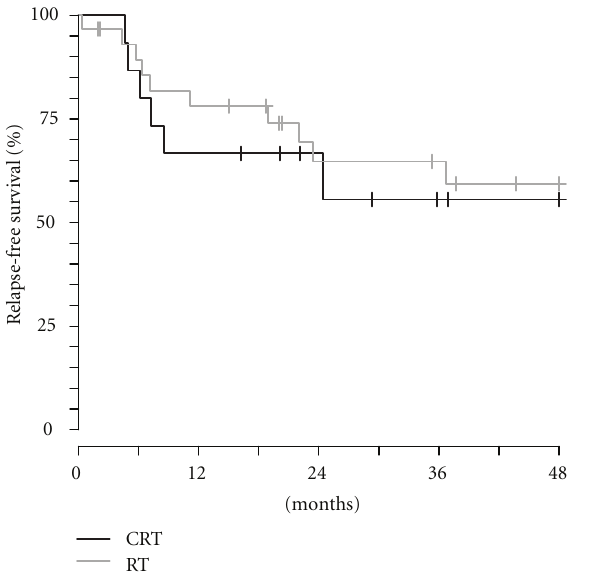
Figure 3: The Kaplan Meier estimates of relapse-free survival. CRT: chemoradiotherapy; RT: radiotherapy.